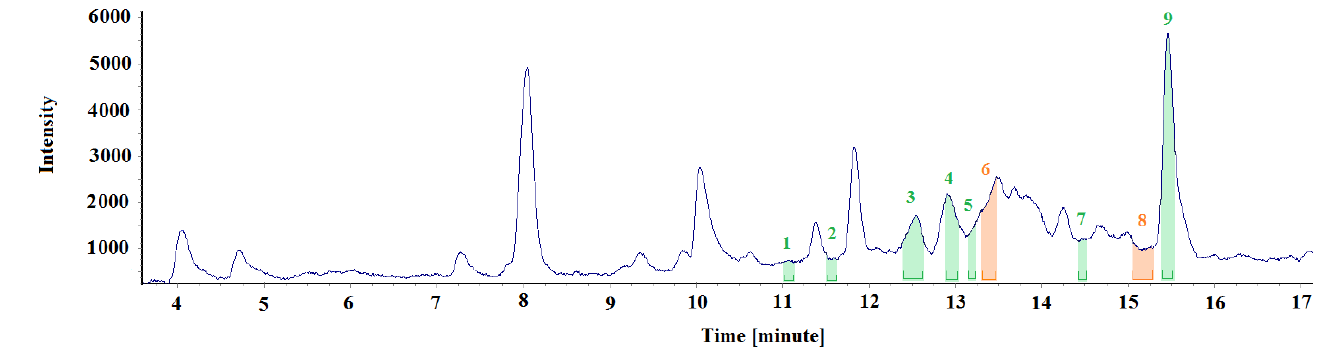
Figure 6. Chromatographic spectrum with the applied odour signals obtained for the air sample collected from the non-renovated office room. Table 2. Identification of the signals obtained for the air sample collected from the non-renovated office